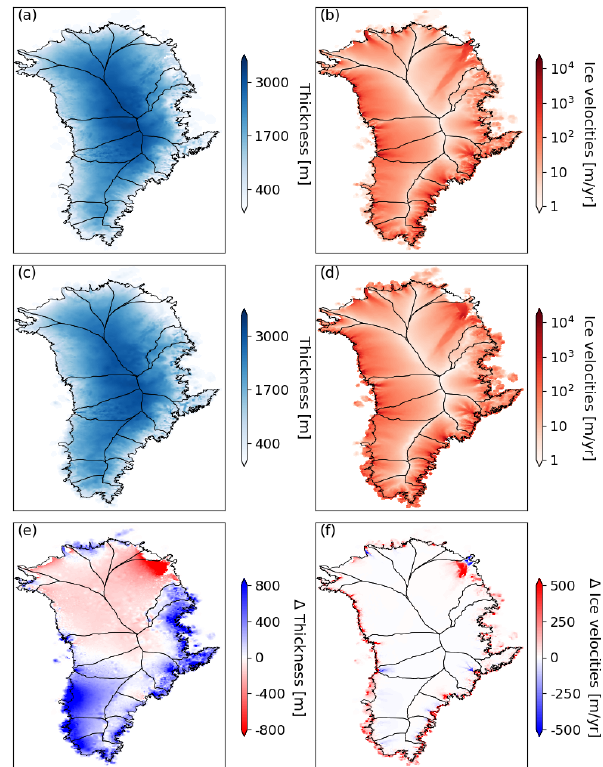
Figure A1. Initial configuration from observational datasets: (a) ice thickness and (b) ice velocities. Configuration of the steady state at the end of the spin-up: (c) ice thickness and (d) ice velocities. Total differences between the steady-state and the initial configurations: (e) ice thickness (c–a) and (f) ice velocities (d–b) .